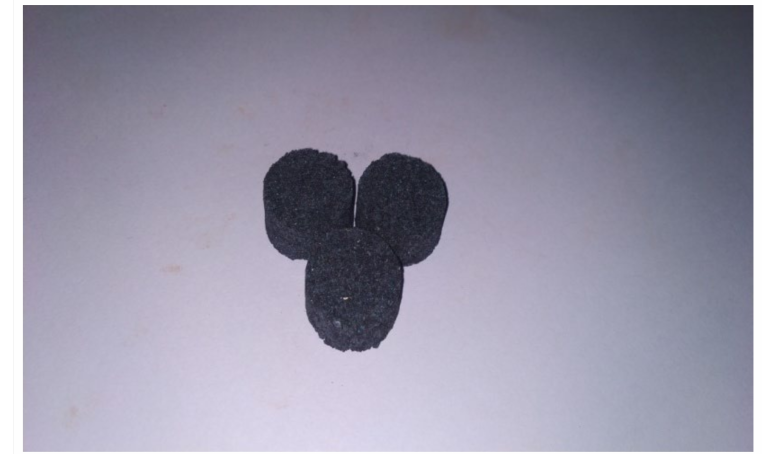
Figure 7. Preforms sintered in conventional